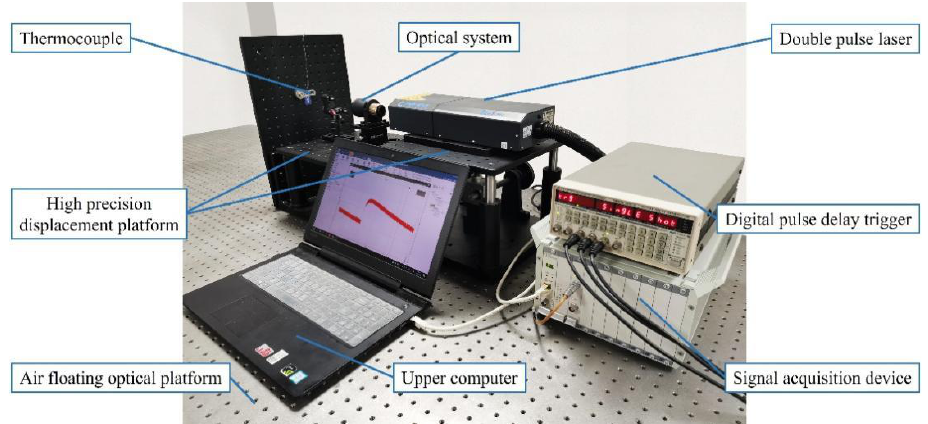
Figure 2. Dynamic calibration experimental device.